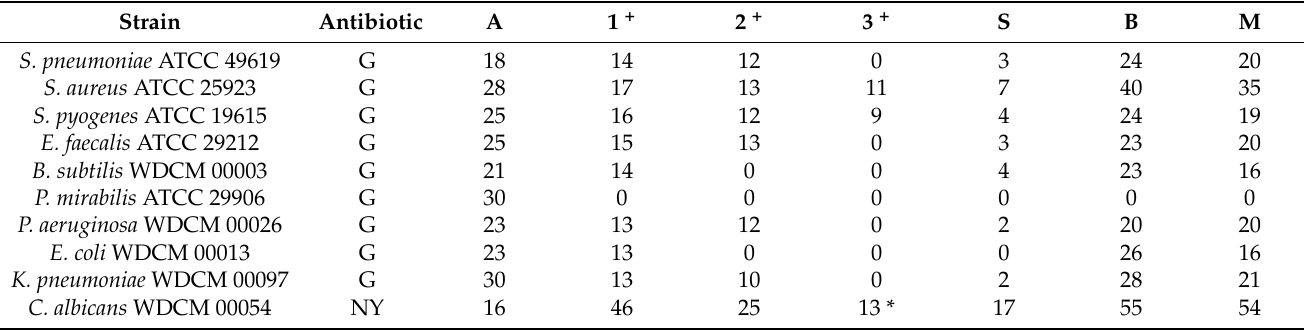
Table 5. Antimicrobial testing of antibiotics (A), AV-PVP-TCA-I 2 by disc dilution studies